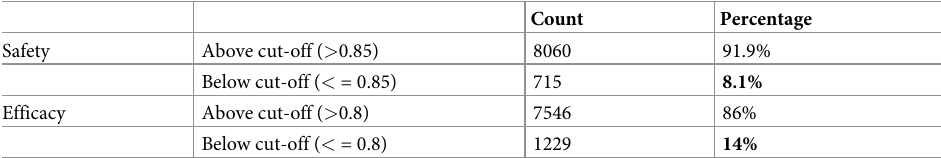
Table 3. Success of safety and efficacy. Count Percentage Safety Above cut-off ( > 0.85) 8060 91.9% Below cut-off ( < = 0.85) Efficacy Above cut-off ( >